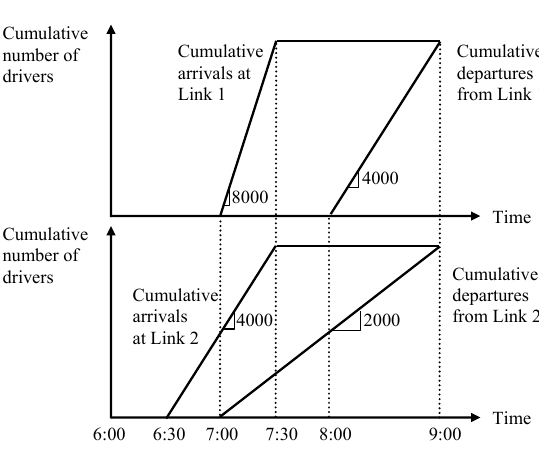
Figure 2 Cumulative arrivals and departures on Links 1 and 2 Figure 2. Cumulative arrivals and departures on Links 1 and